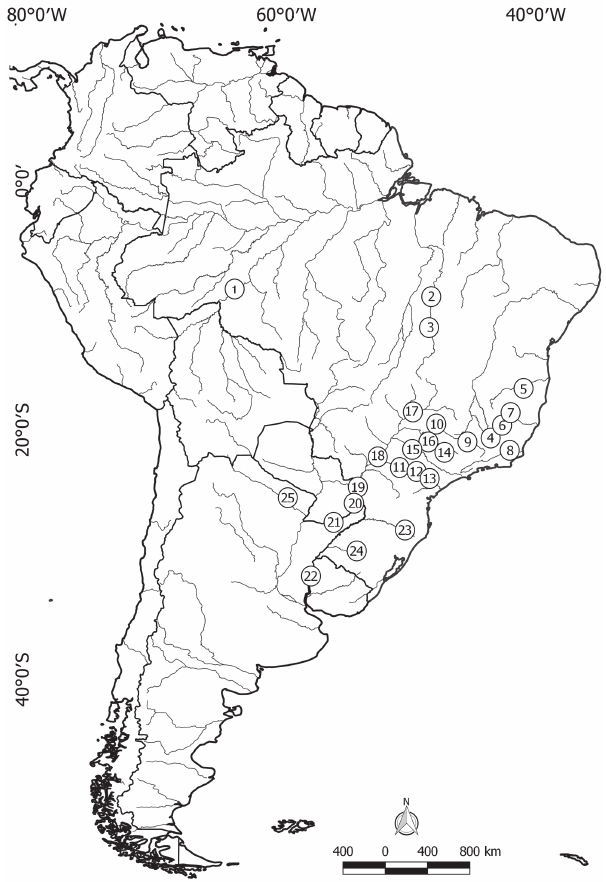
Fig. 1. Spatial distribution of fish passage facilities in South America whose function has been investigated. Identification numbers and respective studies are shown in Tab. 1.